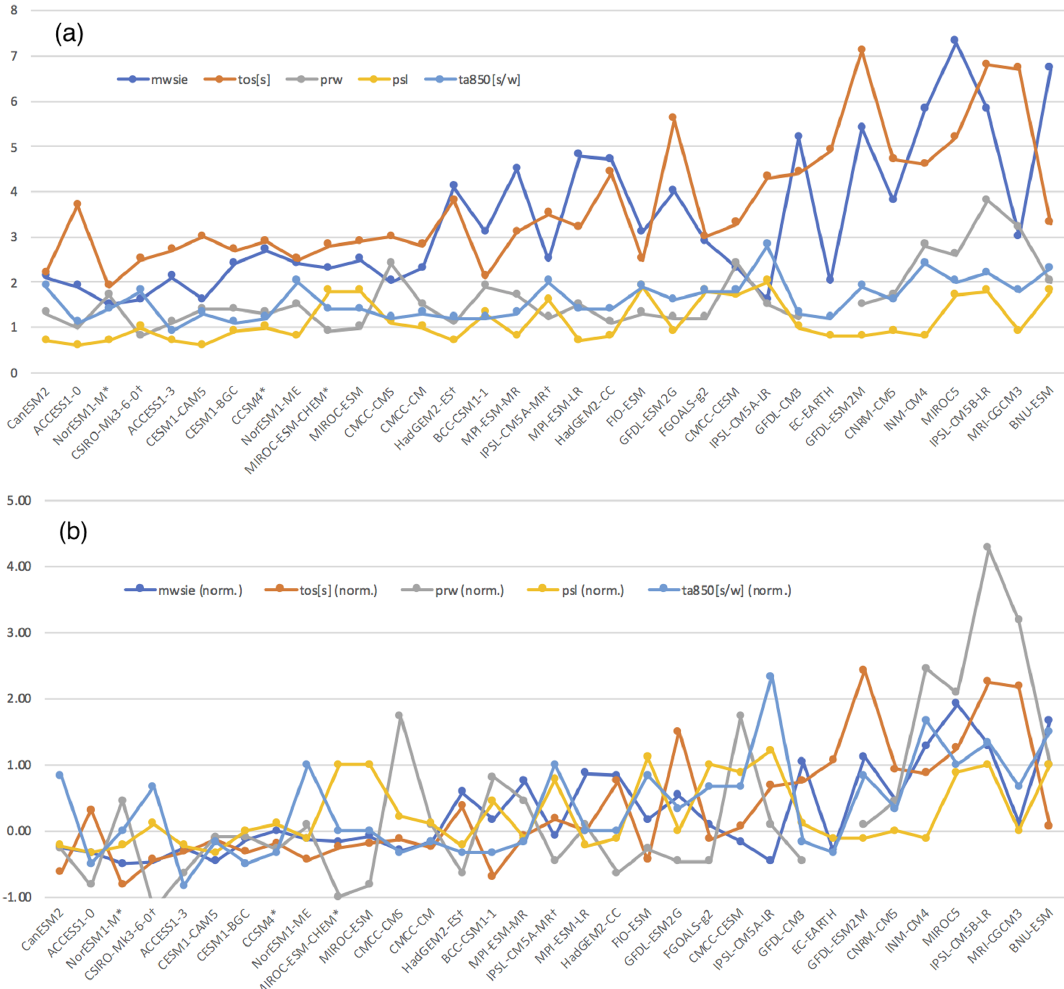
Figure A1. Normalization of variables. (a) Historical atmospheric biases for the Antarctic domain; (b) normalized historical atmospheric bi- ases for the Antarctic domain. The non-normalized variables have different mean values and different variability. The normalization removes the offset and rescales the variability, so that variables of different nature, magnitude, and variability can be combined into one atmospheric bias metric. The * and † symbols identify models selected in the top three and top six ensembles,